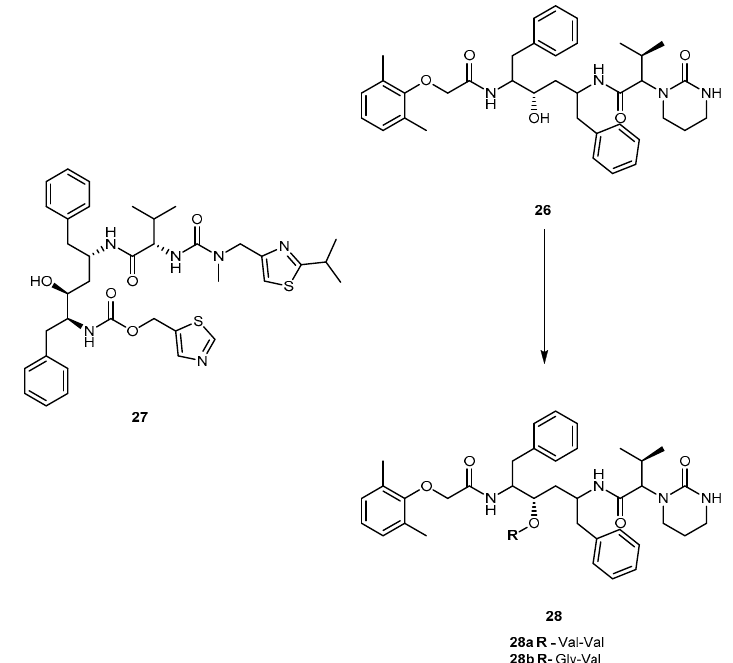
Figure 13. Structures ritonavir ( 27 ) lopinavir ( 26 ) and its dipeptides prodrugs ( 28a and b ) .